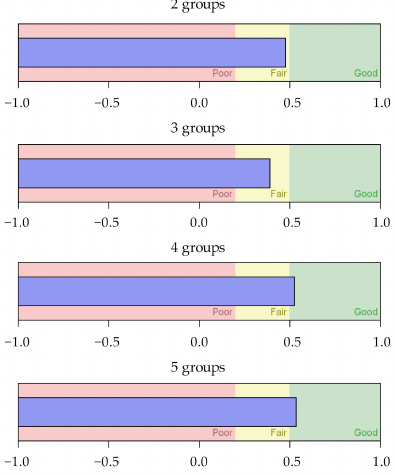
Figure A1. Silhouette measures of cohesion and